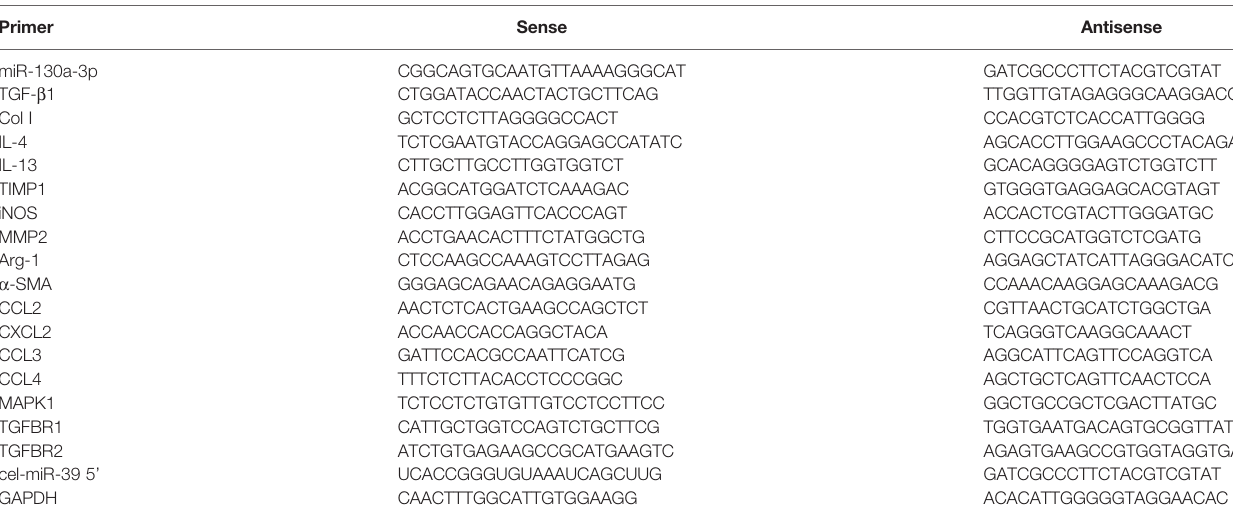
TABLE 1 | The primers used for qRT-PCR.